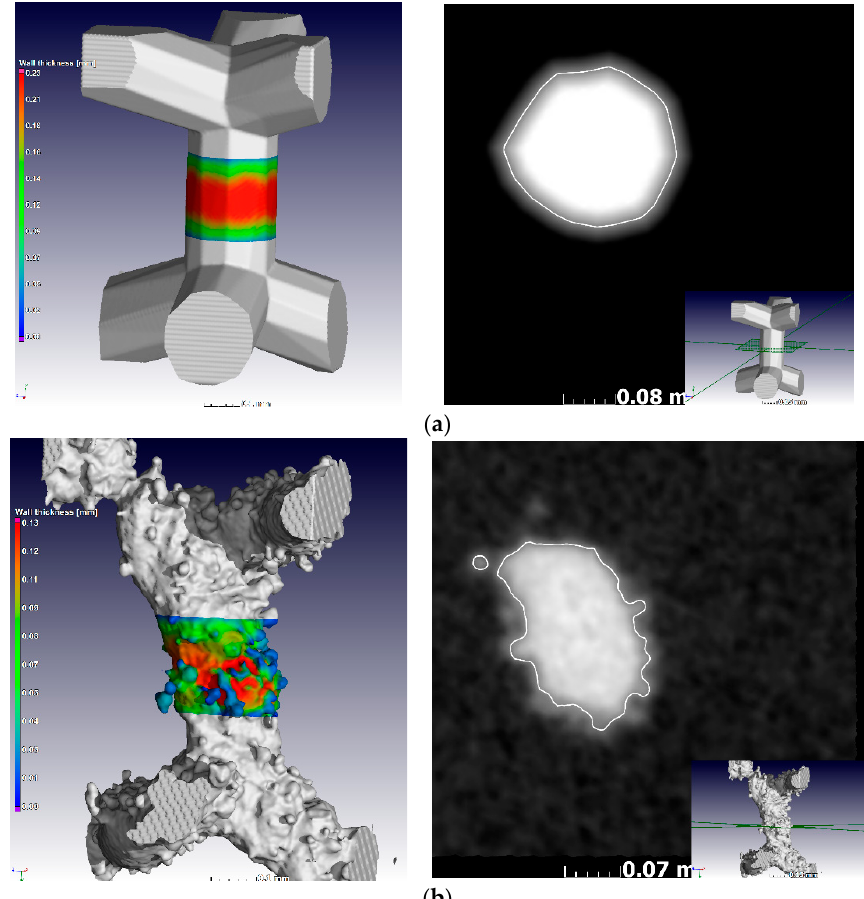
Figure 4 . MicroCT voxel view of ( a ) designed and ( b ) manufactured struts and their cross-sections, indicating the actual morphology in each case.